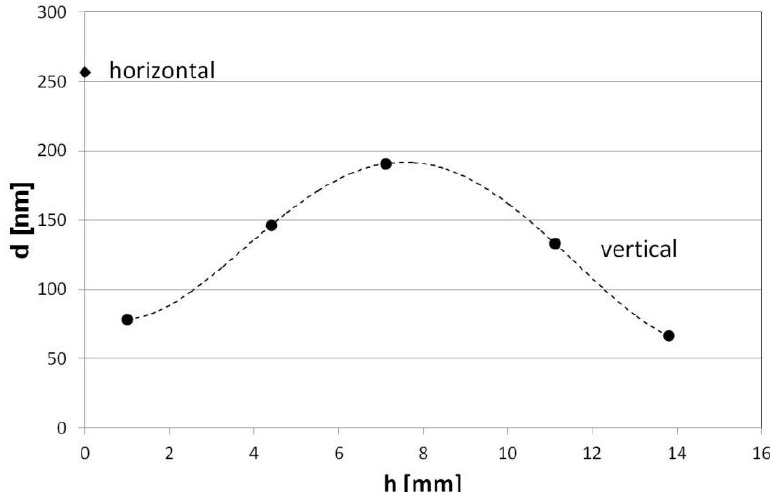
Figure 7. Distribution of d on vertically oriented Si wafers. Thickness of the film on wafer horizontally placed on the holder surface is given for